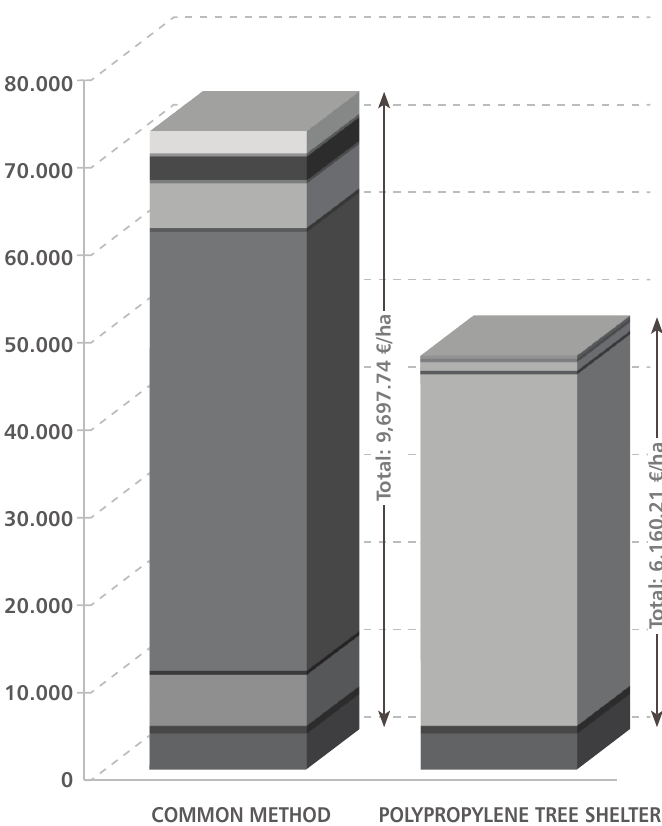
FIGURE 5. Comparison of the cost structure - cost per 1 ha in € of the pedunculate oak stand regeneration of the common me- thod and with the help of the poly- propylene tree shelter (middle rate published by the Croatian National Bank on 3 rd January